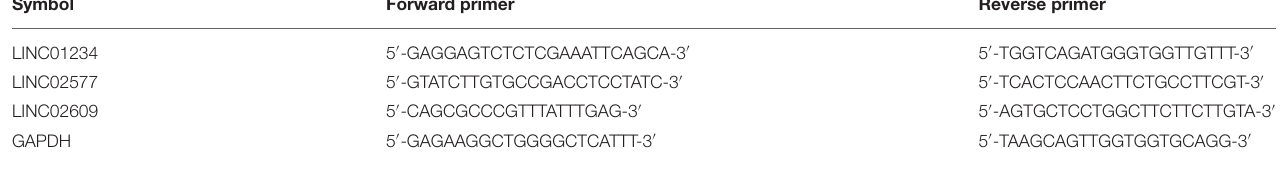
TABLE 2 | Primers for qRT-PCR of the 3 distant metastasis-related lncRNAs. Symbol